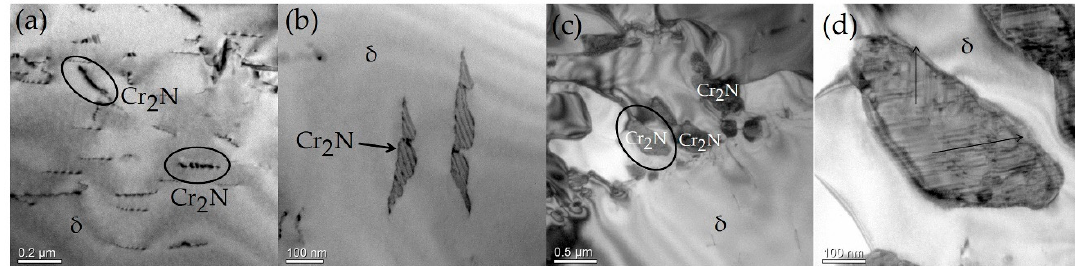
Figure 2. ( a ) TEM micrograph of a specimen aged at 600 °C for 7 h, and ( b ) high magnification of ( a ); ( c ) TEM micrograph of a specimen aged at 750 °C for 5 h, and ( d ) high magnification of ( c ), showing the many fringes in Cr 2 N.